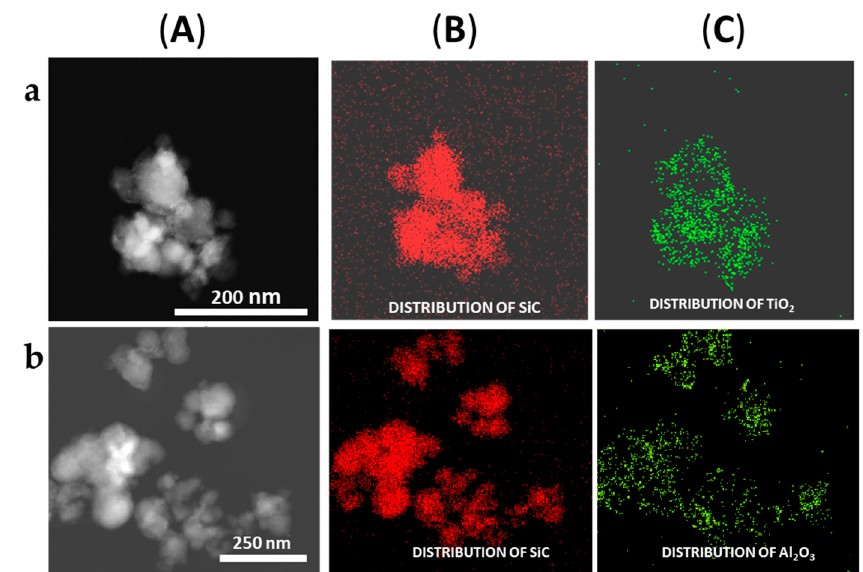
Figure 6. Representative images of the ( a ) TiO 2 @SiC and ( b ) Al 2 O 3 @SiC core–shell NPs obtained in the up-scaling process (STEM-EDX, mapping tool). ( A ) Direct electron image; ( B ) Signal coming from the SiC particles (Si Κα1 radiation); and ( C ) Signal coming from the shell (corresponding MK α 1 radiation).